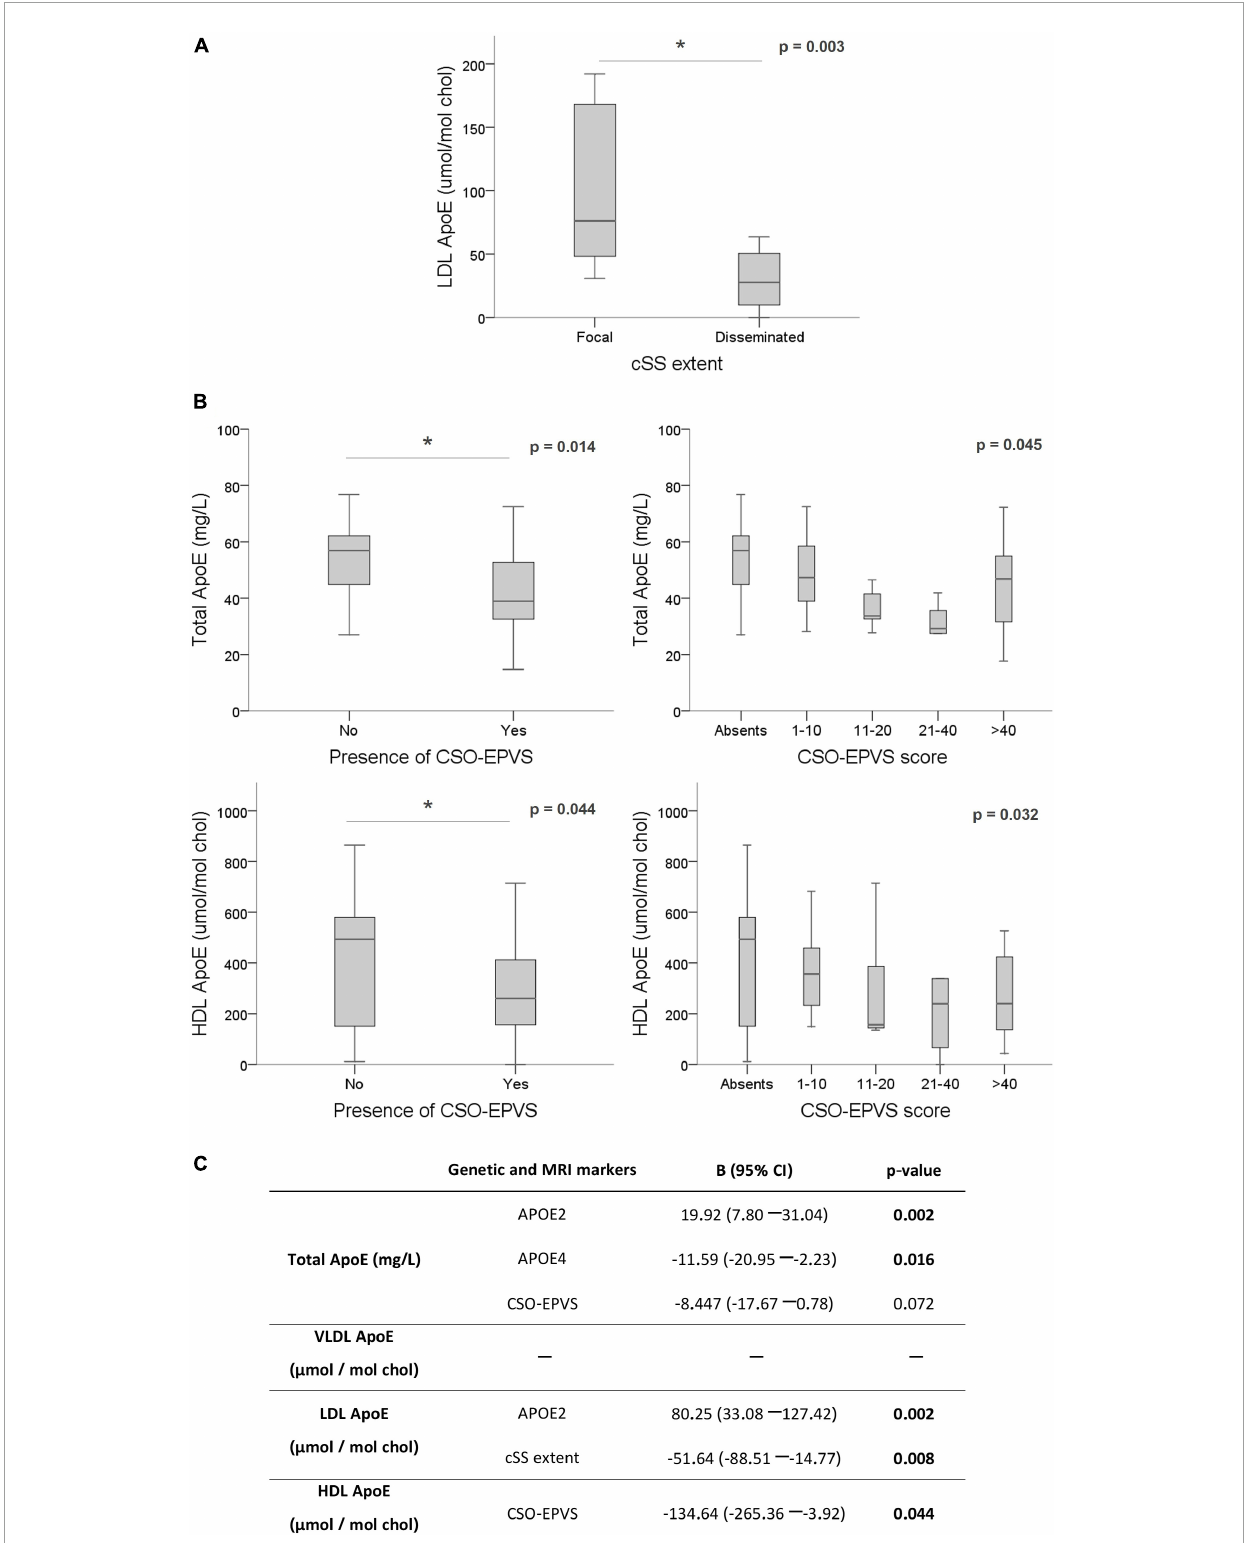
FIGURE4 Association of ApoE levels with MRI features. ApoE levels are expressed as mg/L in plasma and µ mol of ApoE per mol of cholesterol in each lipoprotein. (A) Boxplot distribution of ApoE levels in LDL according to cortical superficial siderosis severity and distribution. (B) Total and HDL ApoE levels according to EPVS in centrum semiovale (CSO). (C) Linear regression for circulating ApoE levels using the significant variables for each lipoprotein fraction (APOE genotypes and MRI markers) and adjusting by sex and age. * p <